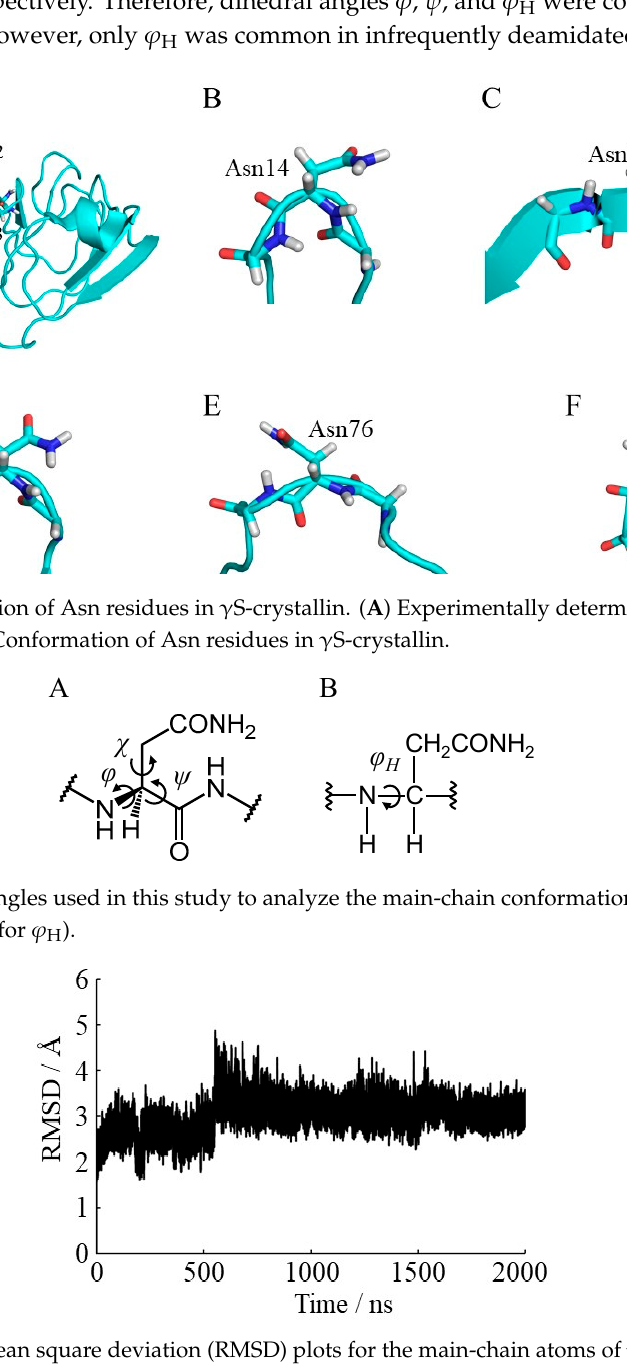
Figure 5. Root mean square deviation (RMSD) plots for the main-chain atoms of γ S-crystallin.